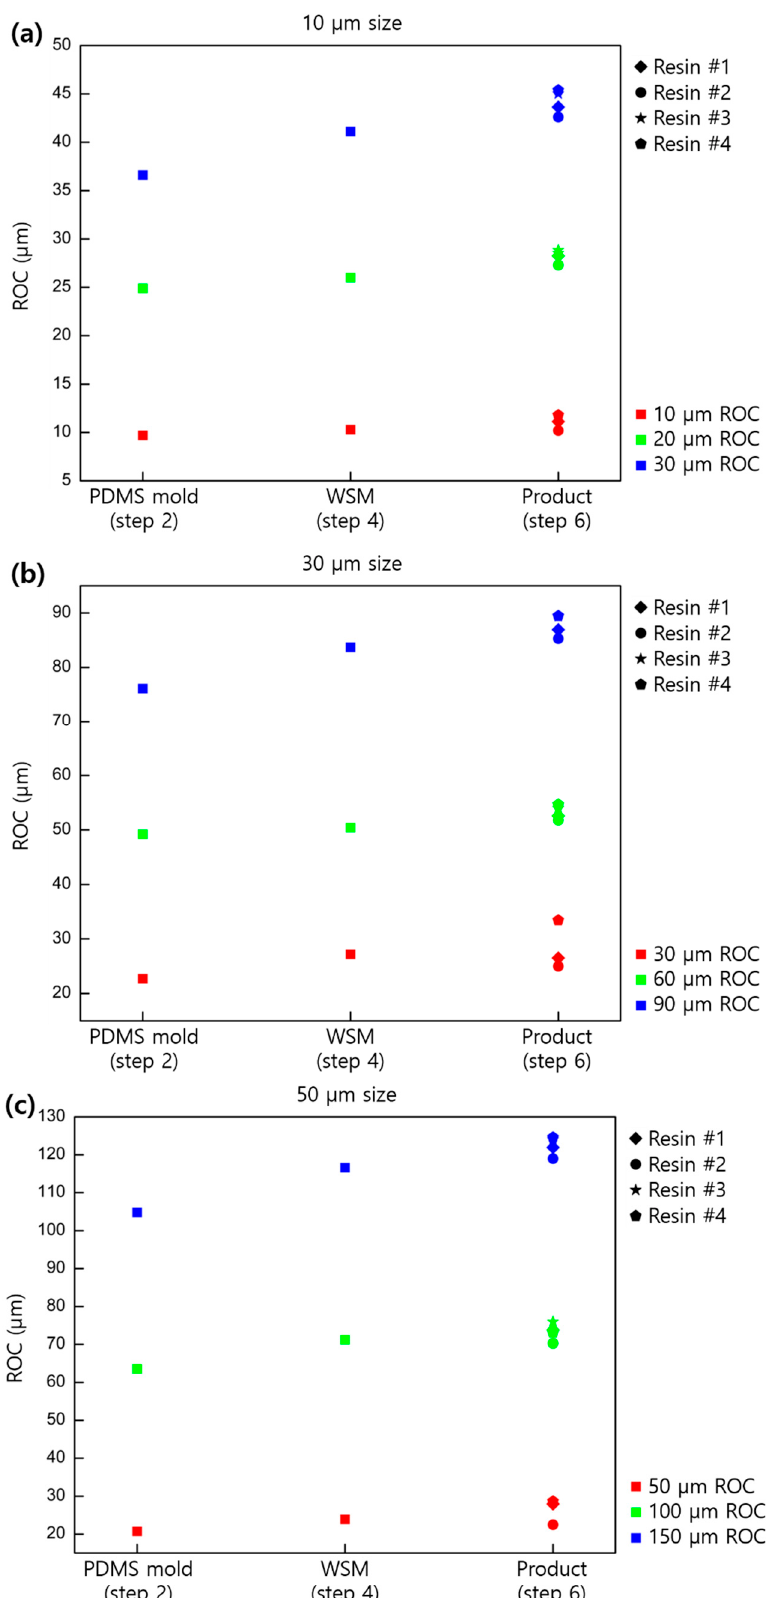
Figure 6. ROC of lens variances based on lens size and shapes for the concave replicated samples: ( a ) 10, ( b ) 30, ( c ) and 50 µm in pitch.